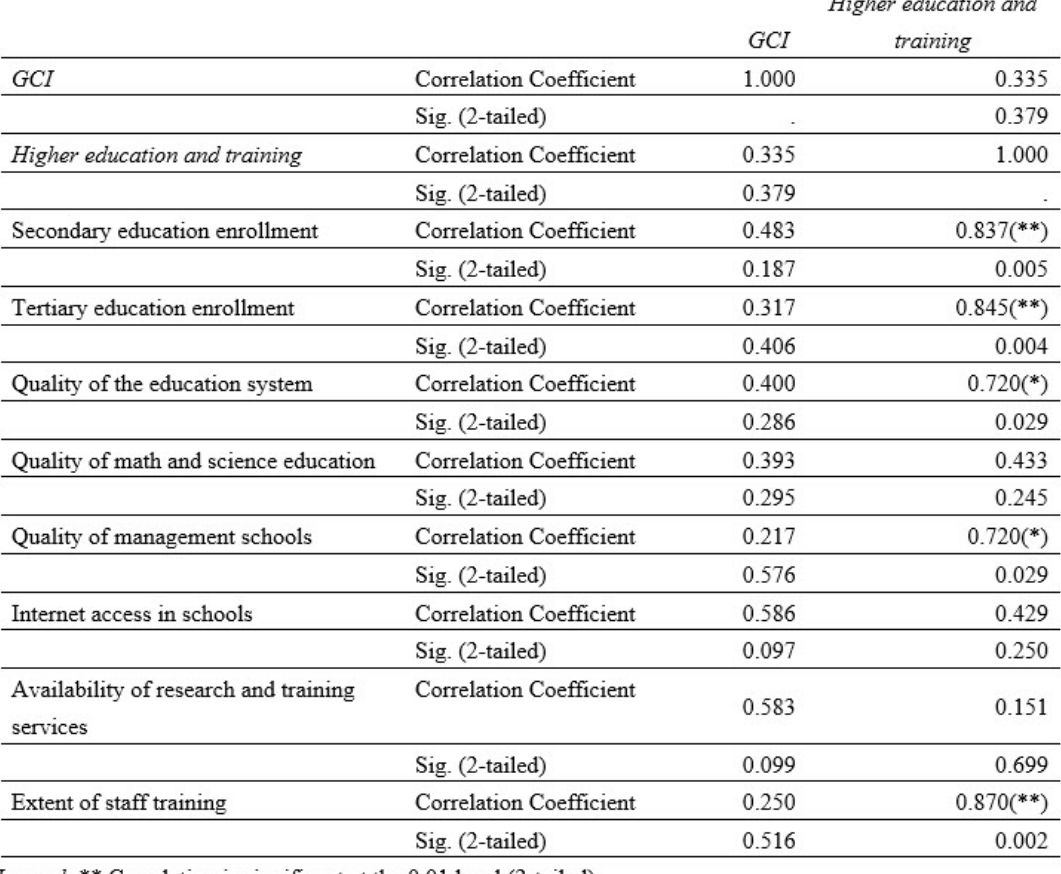
Table 3. Values of the Spearman's rank correlation